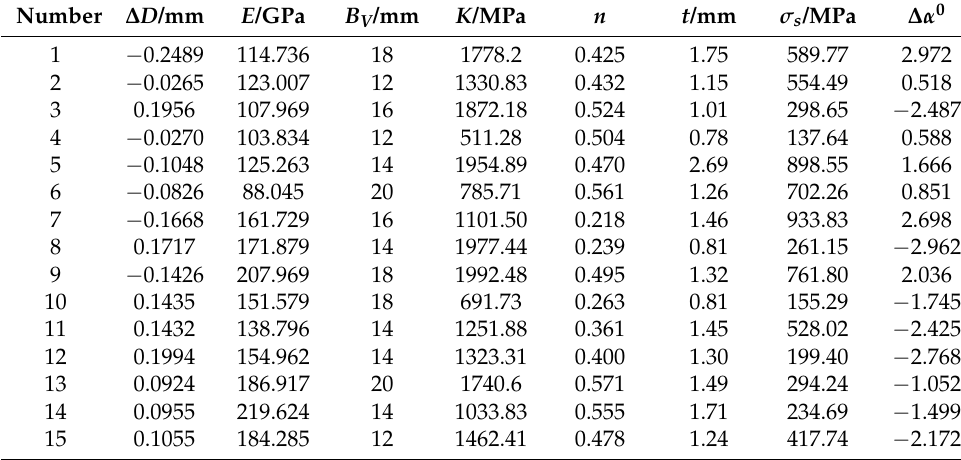
Table 8. Testing samples for the correction